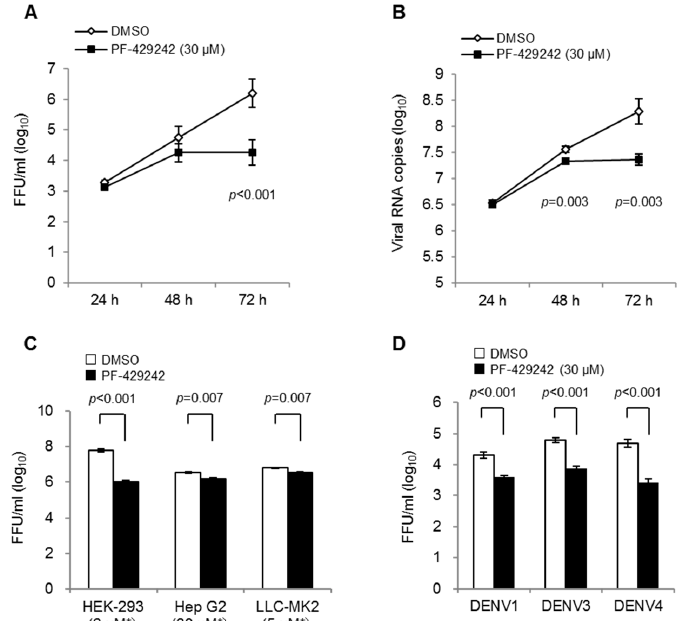
Figure 1. DENV suppression via the addition of PF-429242. ( A,B ) HeLa cells were infected with the DENV2 16681 strain at MOI 1 containing 30 μM of PF-429242 or DMSO alone (control) in the medium. Infectious viral titers ( A ) and viral RNA copy numbers ( B ) in the culture fluids at 24, 48 and 72 h were determined by focus-forming assay and real-time RT-PCR, respectively; ( C ) Infectious viral titers in the cell culture fluids of several cells at 72 h p.i. HEK-293, Hep G2, and LLC-MK2 cells were infected with DENV2 16681 strain at MOI 1 containing 6 μM, 30 μM, and 5 μM of PF-429242 respectively or DMSO only in the medium. Asterisks indicate the concentration of PF-429242; ( D ) Infectious viral titers in the cell-culture fluids of HeLa cells at 72 h p.i. HeLa cells were infected with DENV1 strain from Hawaii, DENV3 SLMC50, and DENV4 SLMC318 at MOI 1 containing 30 μM of PF-429242 or DMSO only in the medium. FFU: focus formation unit. Error bars indicate the standard error (SE). p values: Welch test analysis. Means and S.E. are obtained from 3 of duplicate experiments.